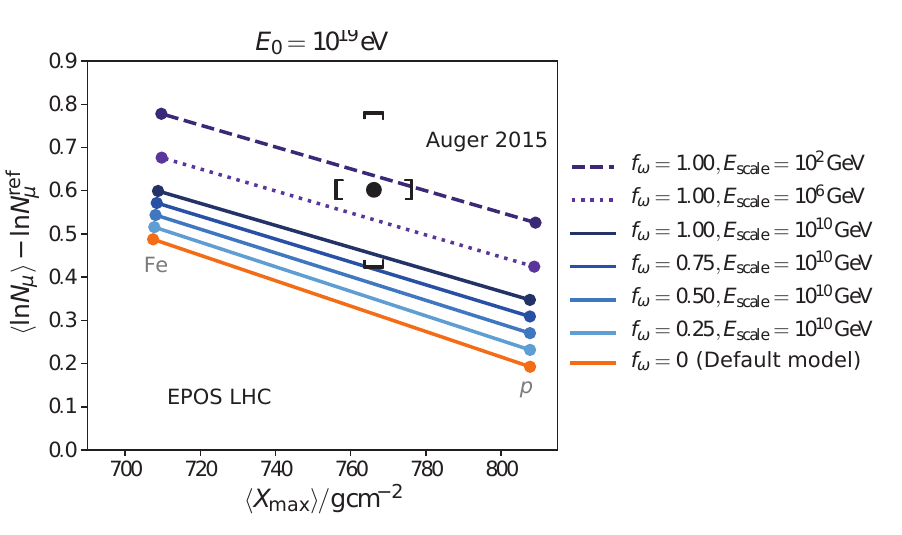
Figure 8. Comparison of di ff erent core-corona mixing scenarios, as described in the text, on air shower simulations at 10 19 eV QGSJ et II.04 in the X max -ln N μ plane. The solid lines represent changing the scale f ω , while the dashed lines also indicate the e ff ect of changing E scale . The default model corresponds to the corona-only simulations. The data point is from the Pierre Auger Observa- tory [42]. Each model line represents all values that can be obtained for any mixture of cosmic nuclei from proton (bottom right) to iron (top